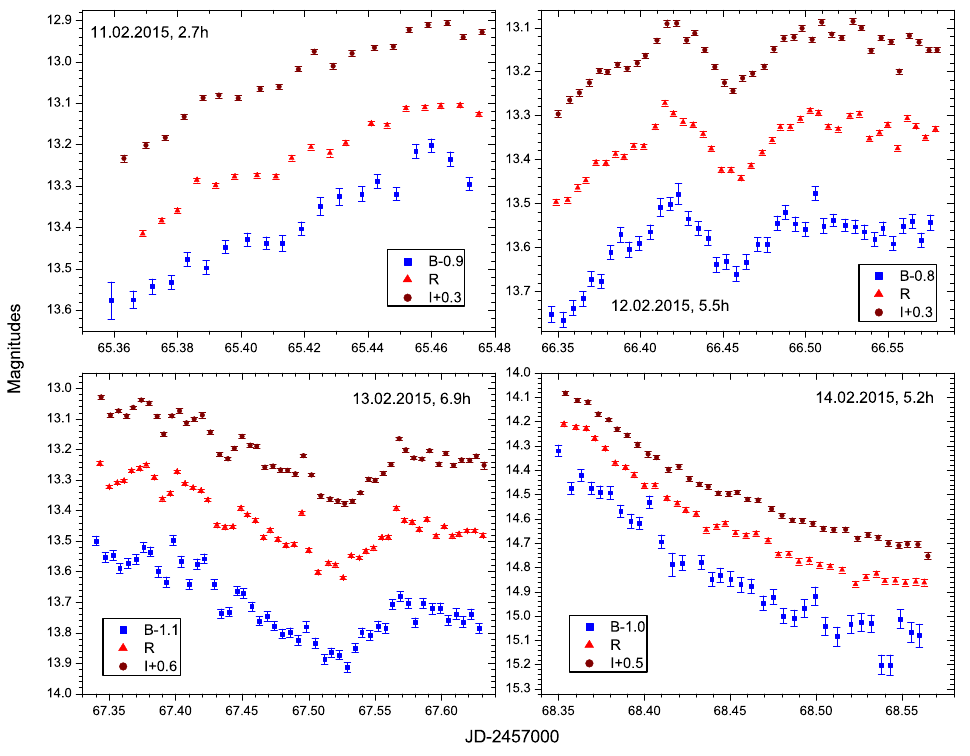
Figure 3. Examples of rapid intra-night variability.